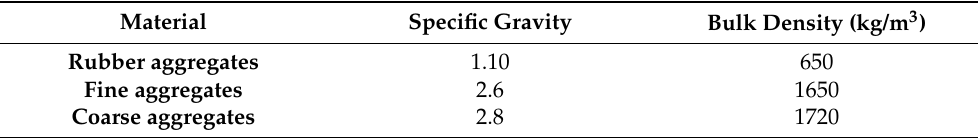
Table 2. Physical properties of materials used as aggregates in the concrete [32]. Copyright© 2017,